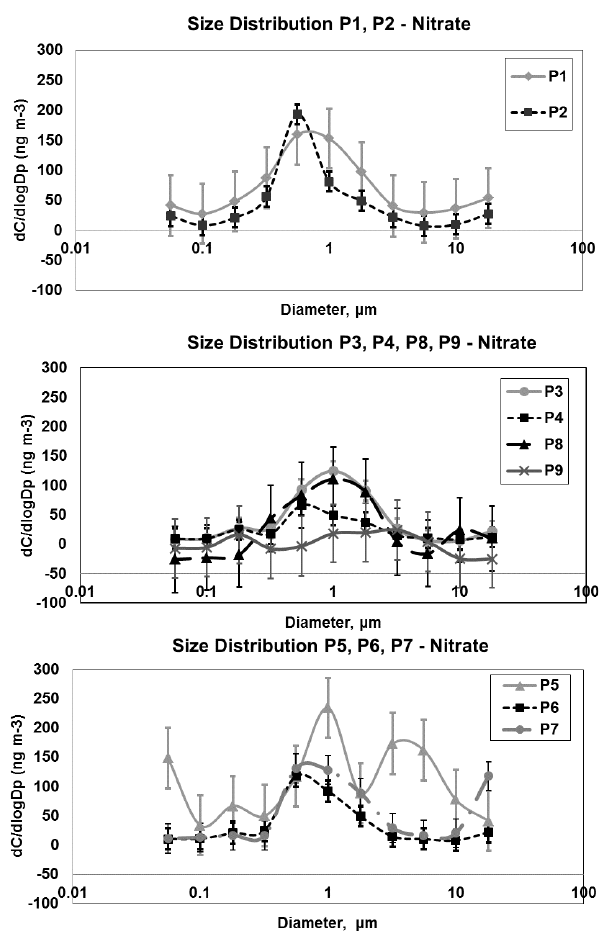
Fig. 6. Normalized size-segregated mass distribution of NO − ing the sampling periods